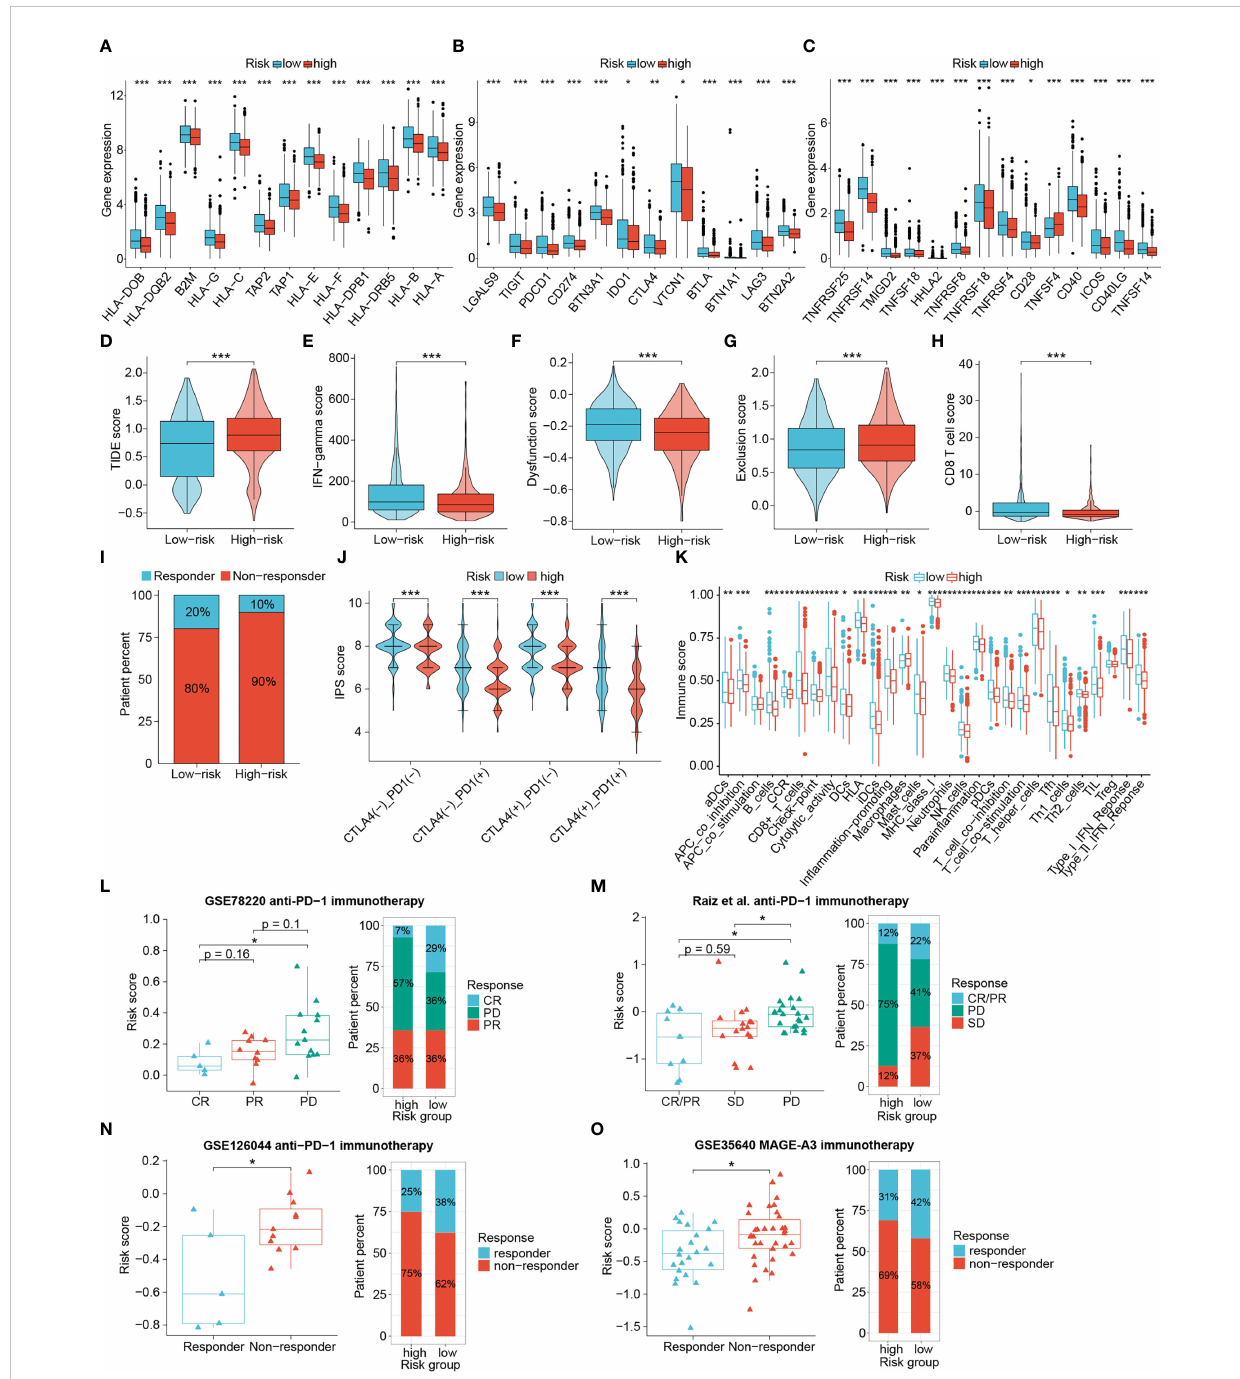
FIGURE 10 The value of the signature in differentiating immunotherapy responses of patients. The differential expression of HLA members (A) , immunoinhibitory molecules (B) and immunostimulatory molecules (C) . Differences in TIDE scores (D) , IFN-gamma scores (E) , T cell dysfunction scores (F) , T cell exclusion scores (G) , CD8+ T cell scores (H) , percentage of immunotherapy responders (I) , IPS scores (J) and immune function scores (K) between risk groups. (L – O) Four immunotherapy cohorts validated the predictive performance of the signature. (*P < 0.05, **P < 0.01, ***P <